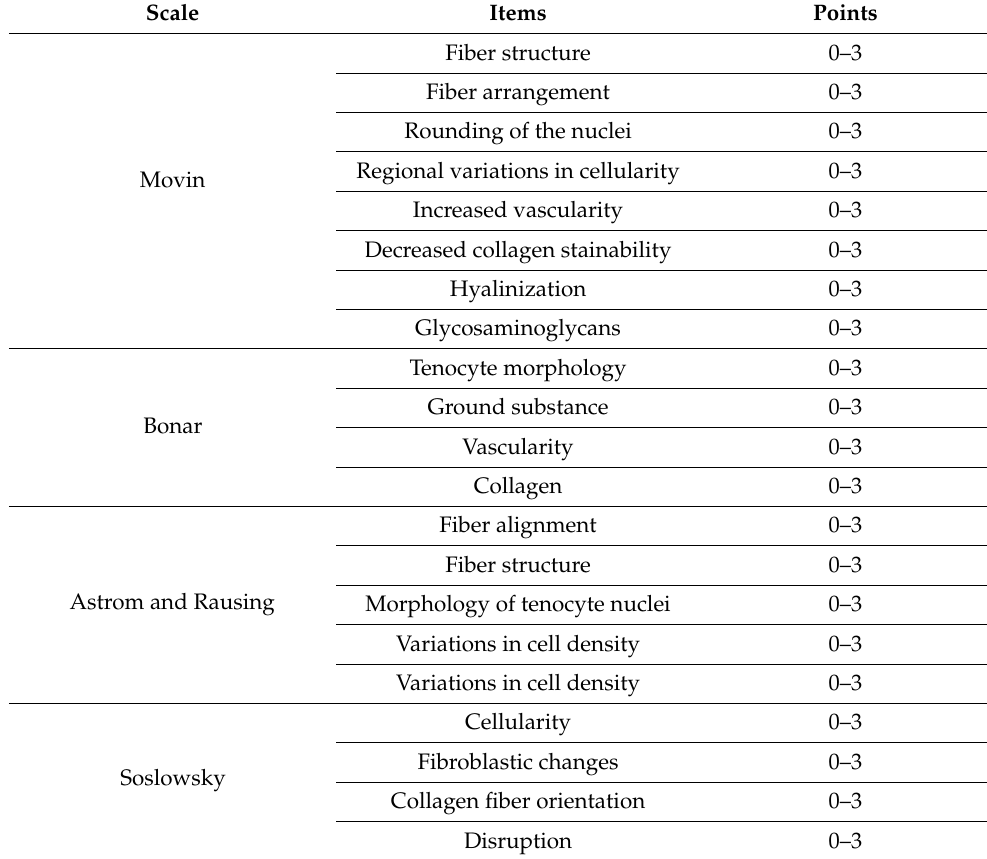
Table 1. The most popular scoring systems in tendon pathology assessment. Scale